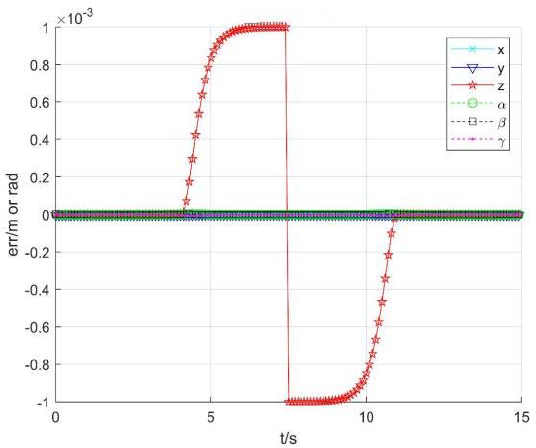
Figure 16. The constant b.